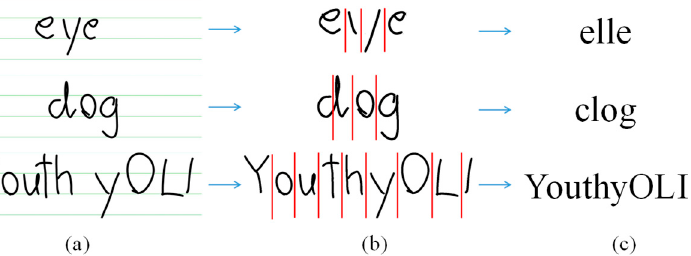
Figure 17. Some images of correct segmentation and recognition: ( a ) Images input into the system, ( b ) images with segmentation lines, and ( c ) recognition results.